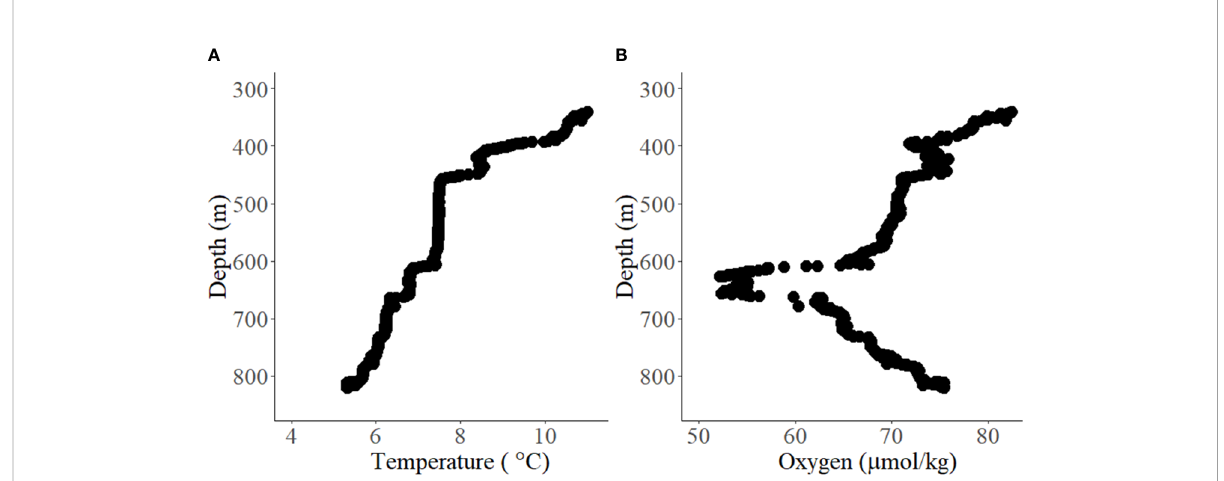
FIGURE 3 Environmental conditions near the sea fl oor throughout Dive 5, Jarvis Island ( NOAA Ship Okeanos Explorer , EX1705). (A) Temperature (°C) recorded the two-bodied ROV system Deep Discoverer and Seirios by depth (m). (B) Oxygen concentration in µmol/kg by depth recorded throughout the dive.